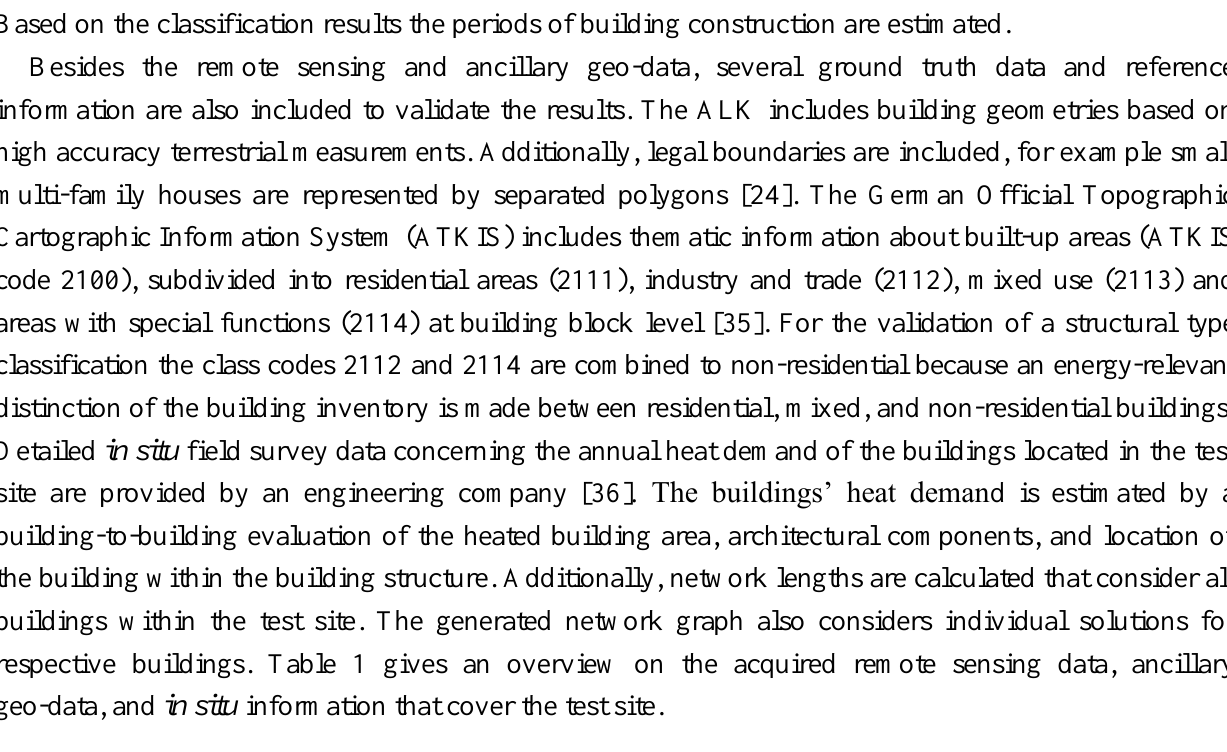
Table 1. Overview of the used remote sensing data, ancillary geo data, and in situ